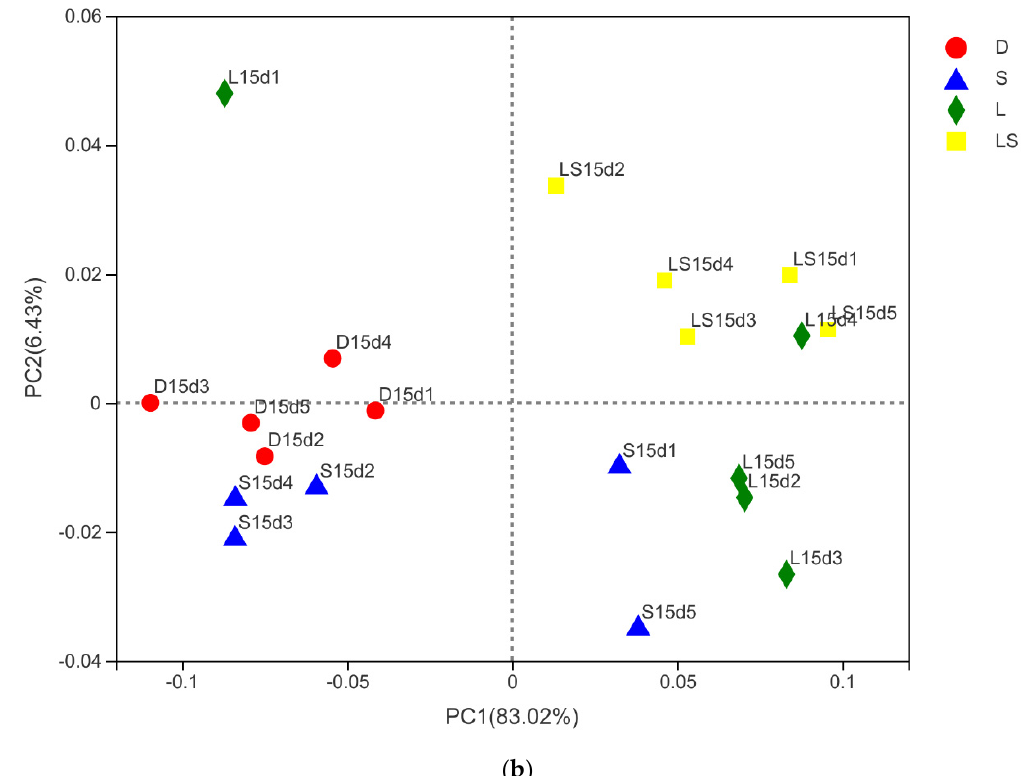
Figure 1. Relationships between the gut microbiota of newborn calves from different probiotic treatment groups. ( a ) Clustering analysis of the evolution of gut microbiotas in newborn calves from the LS, L, S, and D groups ( LS group: lactic acid bacteria + yeast group; L group: lactic acid bacteria group; S group: yeast group; D group: control group ) . Gut microbiota trees were produced making use of the UPGMA algorithm based on the unweighted UniFrac distances generated using QIIME software. ( b ) Principal coordinates analysis of weighted UniFrac distances among the microbial communities of newborn calves in different probiotic groups.